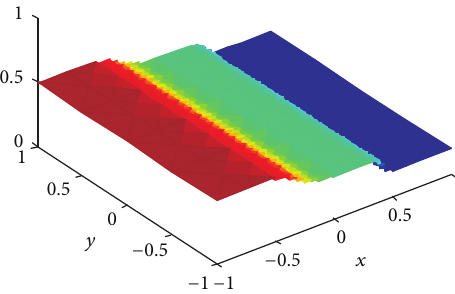
Figure 5: The water surface of the radial dam-break problem at 𝑡 = 0.05 using the adaptive method. The base plane is the 𝑥𝑦 -plane.